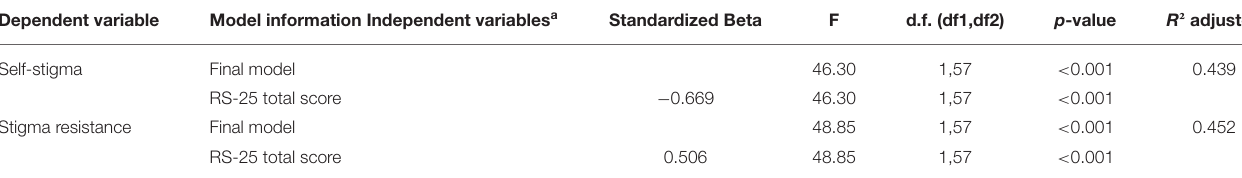
TABLE 3 | Results of multiple linear regression